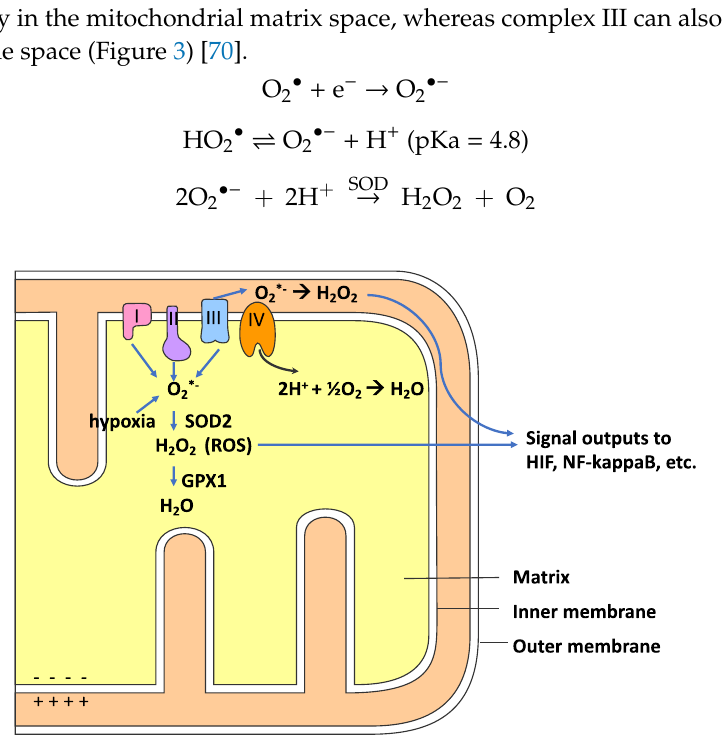
Figure 3. The mitochondrial electron transport chain (ETC) is a major source of reactive oxygen species (ROS). The superoxide anion (O 2•− ) is produced when an electron (e − ) is transferred to oxygen rather than the next electron carrier in the ETC. Complexes I and II produce O 2•− only in